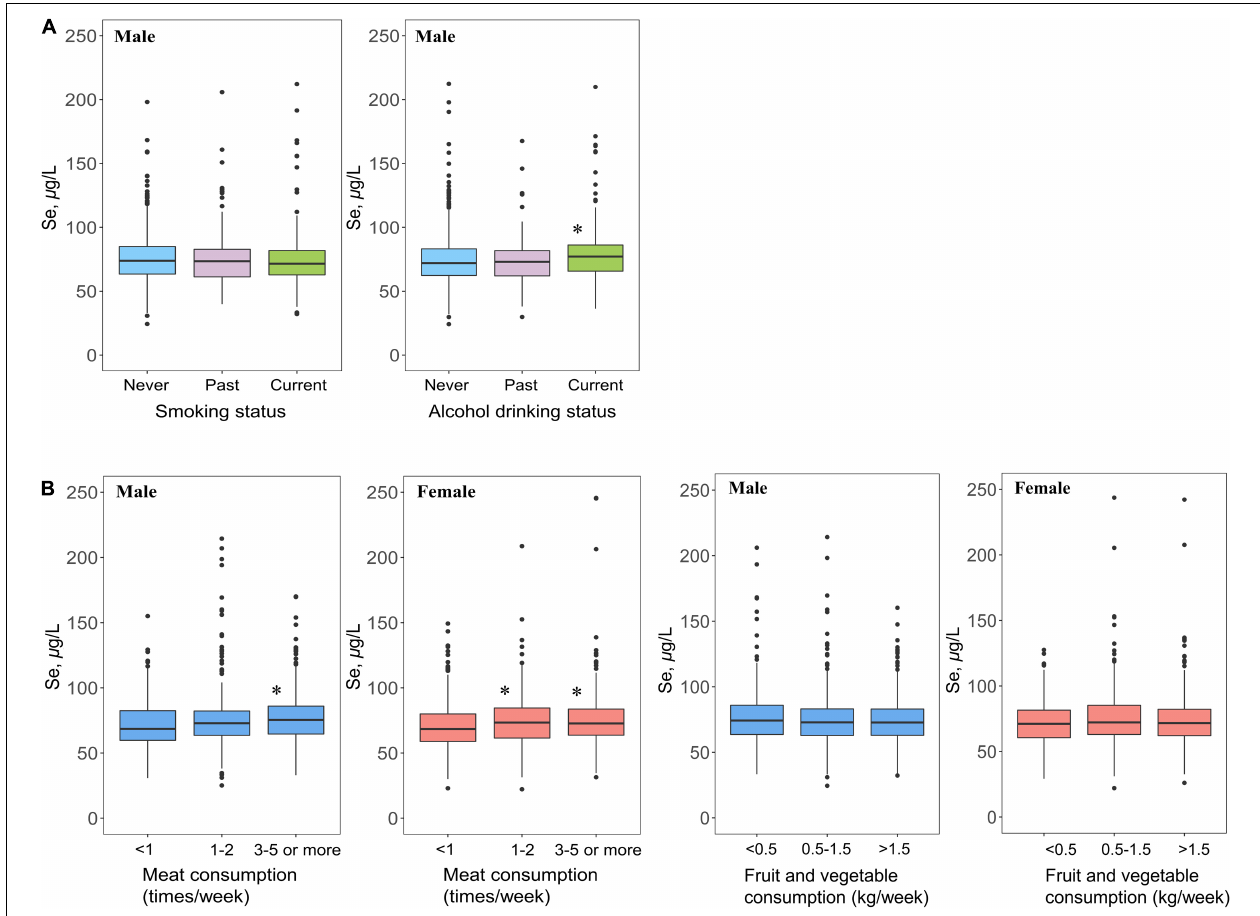
FIGURE 3 | Lifestyle (A) and dietary habits (B) distribution patterns of plasma Se concentrations ( µ g/L) in Chinese middle-aged and elderly adults with hypertension 1 . 1 If not stratified, plasma Se concentrations were adjusted for sex, age, region (Se-marginal, Se-sufficient, and Se-rich areas), BMI, SBP, DBP, history of hypertension, antihypertensive drug use, multivitamin use, smoking, alcohol drinking, meat consumption, and consumption of fruits and vegetables. ∗ p < 0.05, ∗∗ p < 0.001, the average plasma Se concentration of this group significantly differed from non-smokers, those consuming meat less than 1 time/week or consuming fruits and vegetables less than 0.5 kg/week among male and female